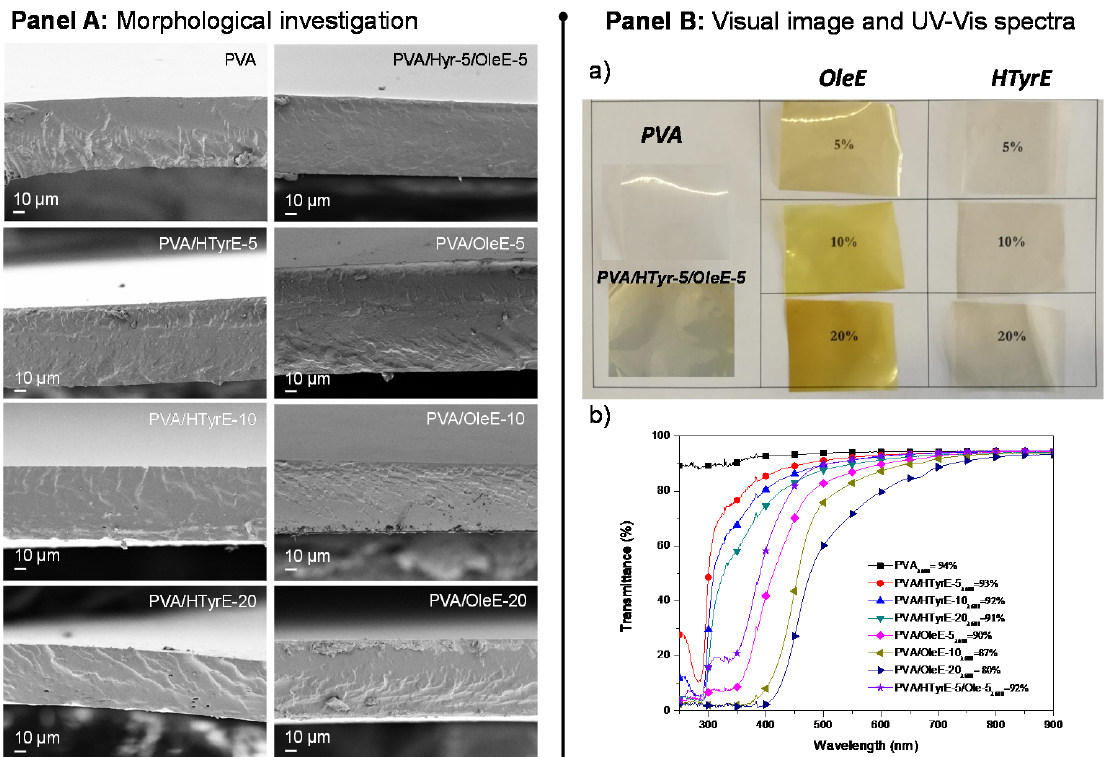
Figure 7. Panel A: FESEM images of fractured surfaces of poly (vinyl alcohol) (PVA), PVA/HTyrE and PVA/OleE films. Panel B: ( a ) Visual image and ( b ) UV-Vis analysis of PVA, PVA/HTyrE and PVA/OleE films.